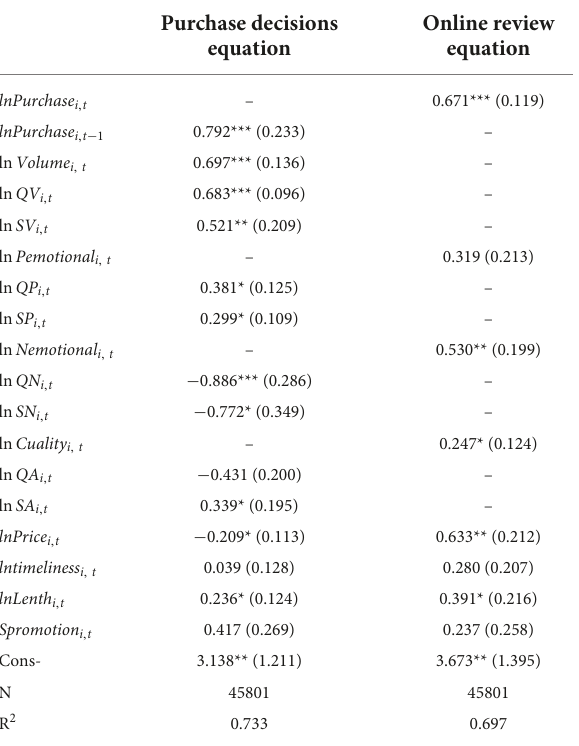
TABLE 5 Regression results of simultaneous